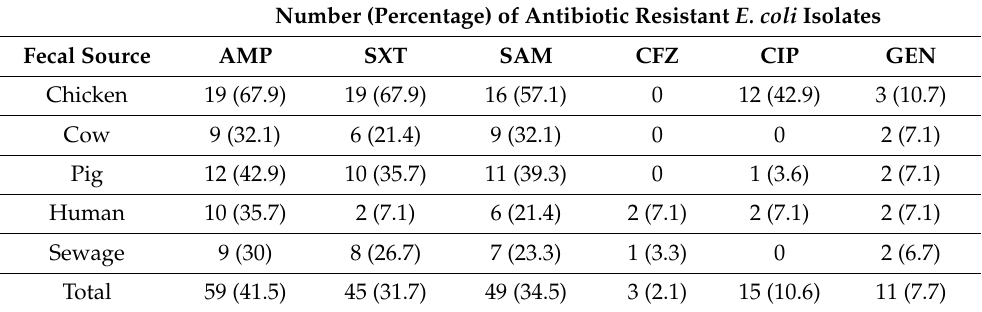
Table 4. Prevalence of antibiotic resistance in E. coli isolates from fecal-associated samples ( n = 142).